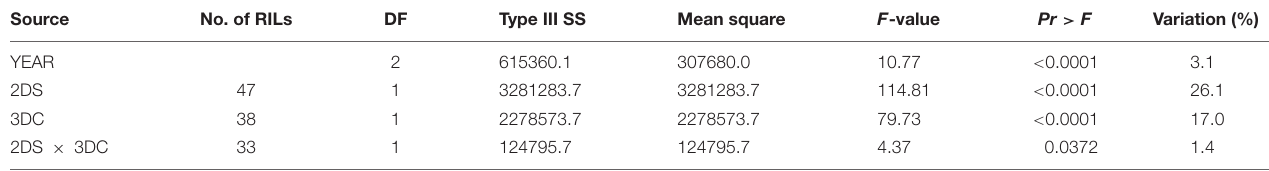
TABLE 3 | Two-way factorial analysis of variance (ANOVA) of area under disease progress curve (AUDPC) for leaf rust resistance loci, using years as blocks. Source No. of RILs